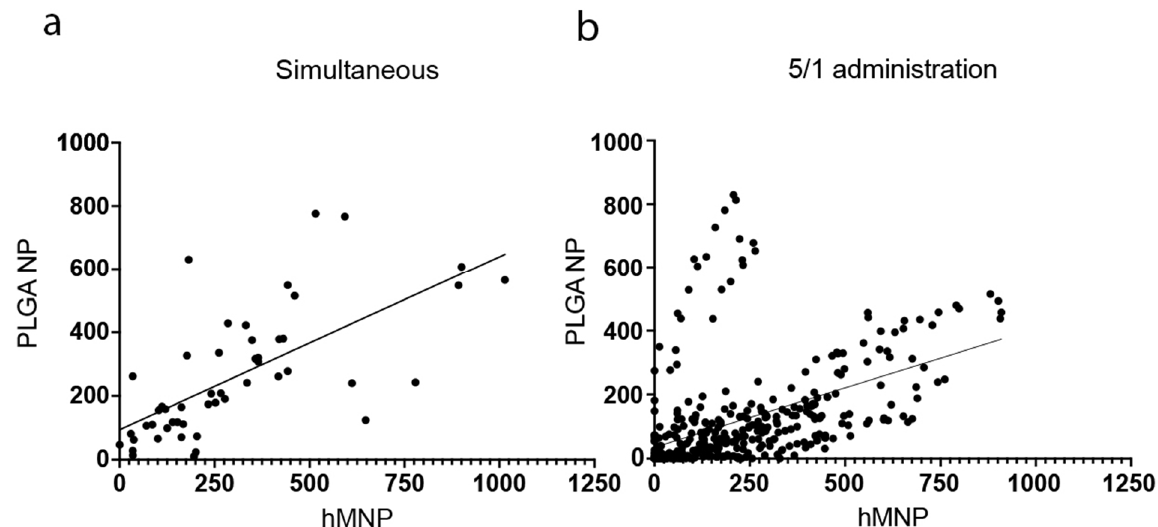
Figure 12. Analysis of the leakage areas for both NP types after different administration regimens. Each point on the graphs represents ROI containing information on the areas ( µ m 2 ) occupied by the NP. ( a ) Analysis of NP distribution upon simultaneous administration. ( b ) Analysis of NP distribution with 5 h/1 h administration regimen. p = 0.0495 .